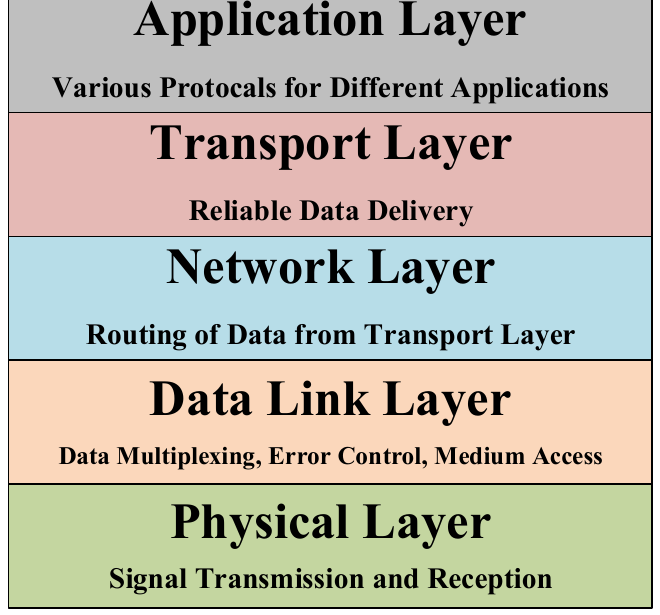
Figure 5 . Protocol stack for WSN . Figure 5. Protocol stack for